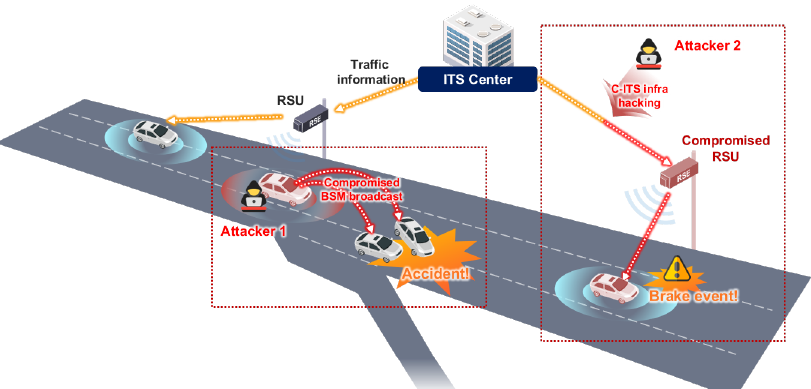
Figure 5. Examples of an attacks using V2X. Attacker 1 is the attacker’s vehicle and causes an accident by sending a compromised BSM to near vehicles. Attacker 2 hacks the C-ITS infrastructure or RSU